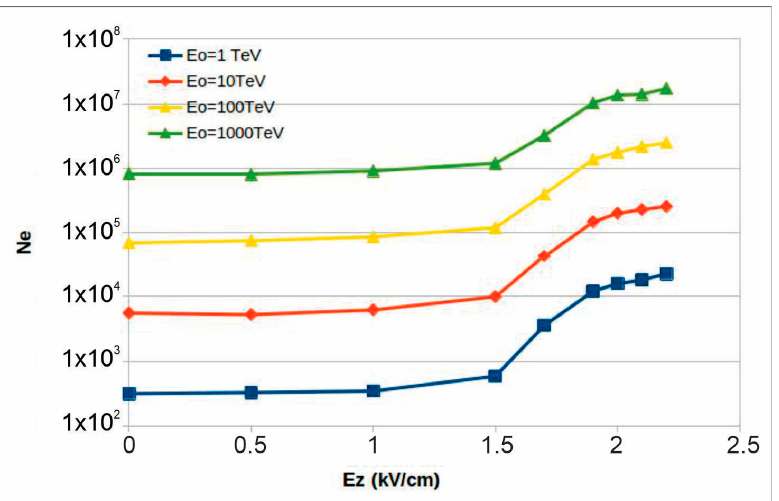
Figure 16. The number of electrons registered on the Earth’s surface after crossing the atmospheric electric field of different strengths. The primary gamma ray enters the electric field at an altitude of 6460 m.